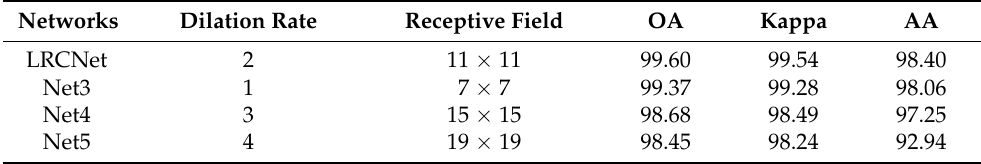
Table 6. The classification accuracy of different receptive fields (%).